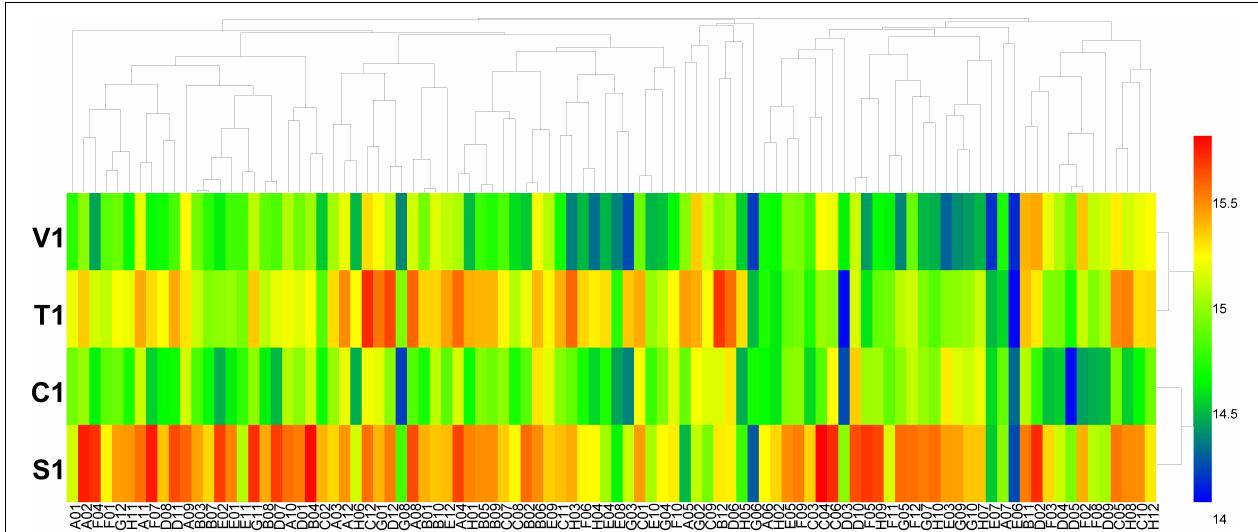
FIGURE 3 | Overview of metabolic phenotypes of four isolates of B. cinerea on 59 phosphorous (P) sources and 35 sulfur (S) sources tested. V1, T1, C1, and S1 were the isolates of B. cinerea from tomato, tobacco, cucumber, and strawberry, respectively. Heatmap of maximum area values of 59 P and 35 S sources expressed as maximum curve area monitored during 96 h of incubation. The legend of color code from blue to green, and red shades indicate low, moderate, and high utilization of both P and S sources, respectively, assessed as arbitrary Omnilog